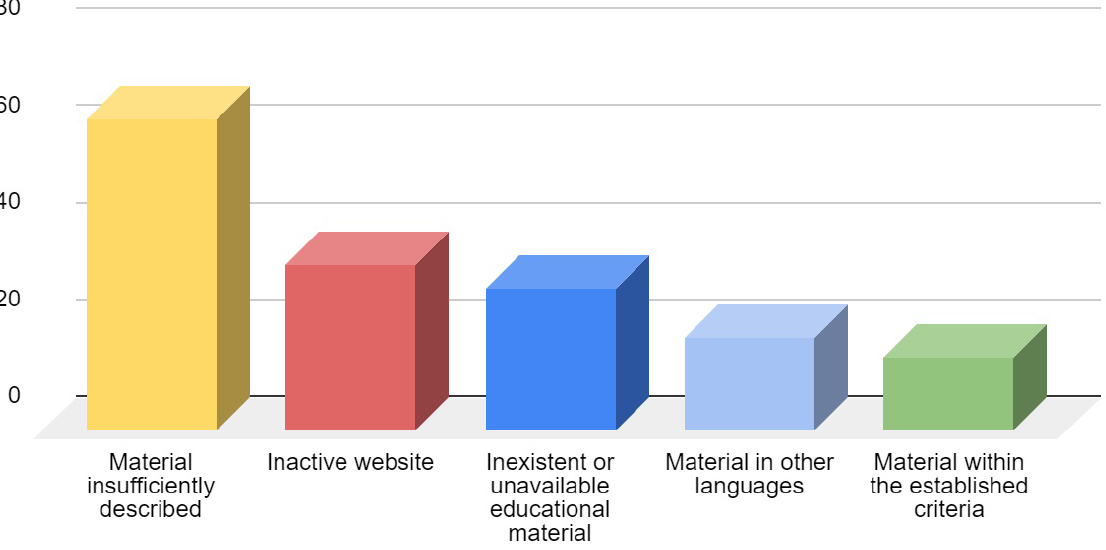
Figure 1. Synthesis of educational materials on the UNESCO Global Geoparks websites.\